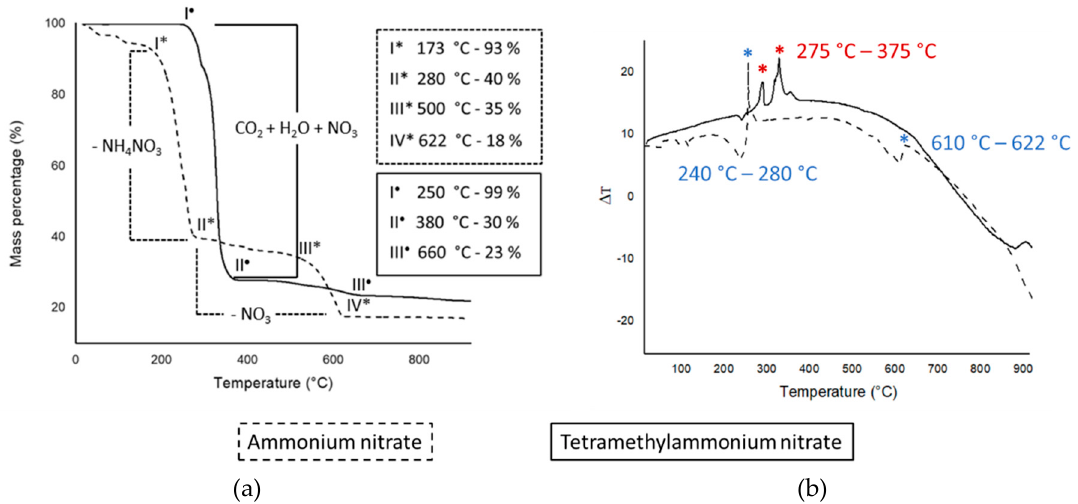
Figure 6. ( a ) TGA analysis, and ( b ) differential thermal analysis (DTA) analysis of the synthesis of YBCO (123) superconductor via 5:1 molar ratio of ammonium nitrate and tetramethyl ammonium nitrate/YBaCu nitrates.